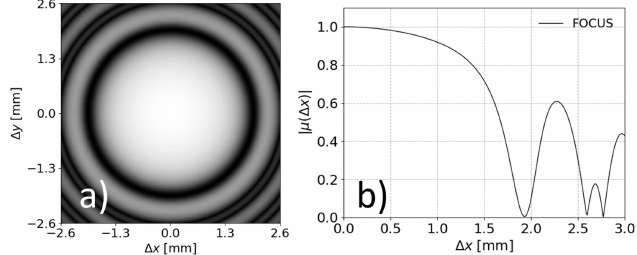
Figure 6 2D map of the on-axis SDC as a function of (cid:2) x and (cid:2) y ( a ), and corresponding horizontal profile at (cid:2) y = 0 ( b ), for a typical fourth- generation synchrotron light source close to the diffraction